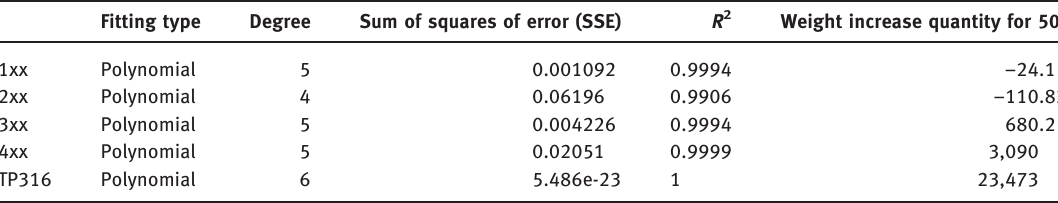
Table 3: Comparison analysis of fitting function for five different materials. Fitting